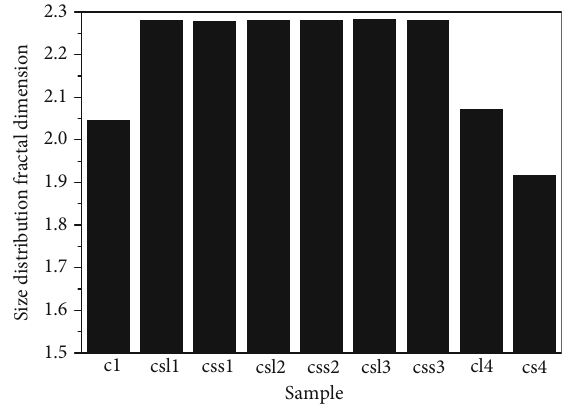
Figure 4: Comparison of fractal dimensions of particle size distributions.